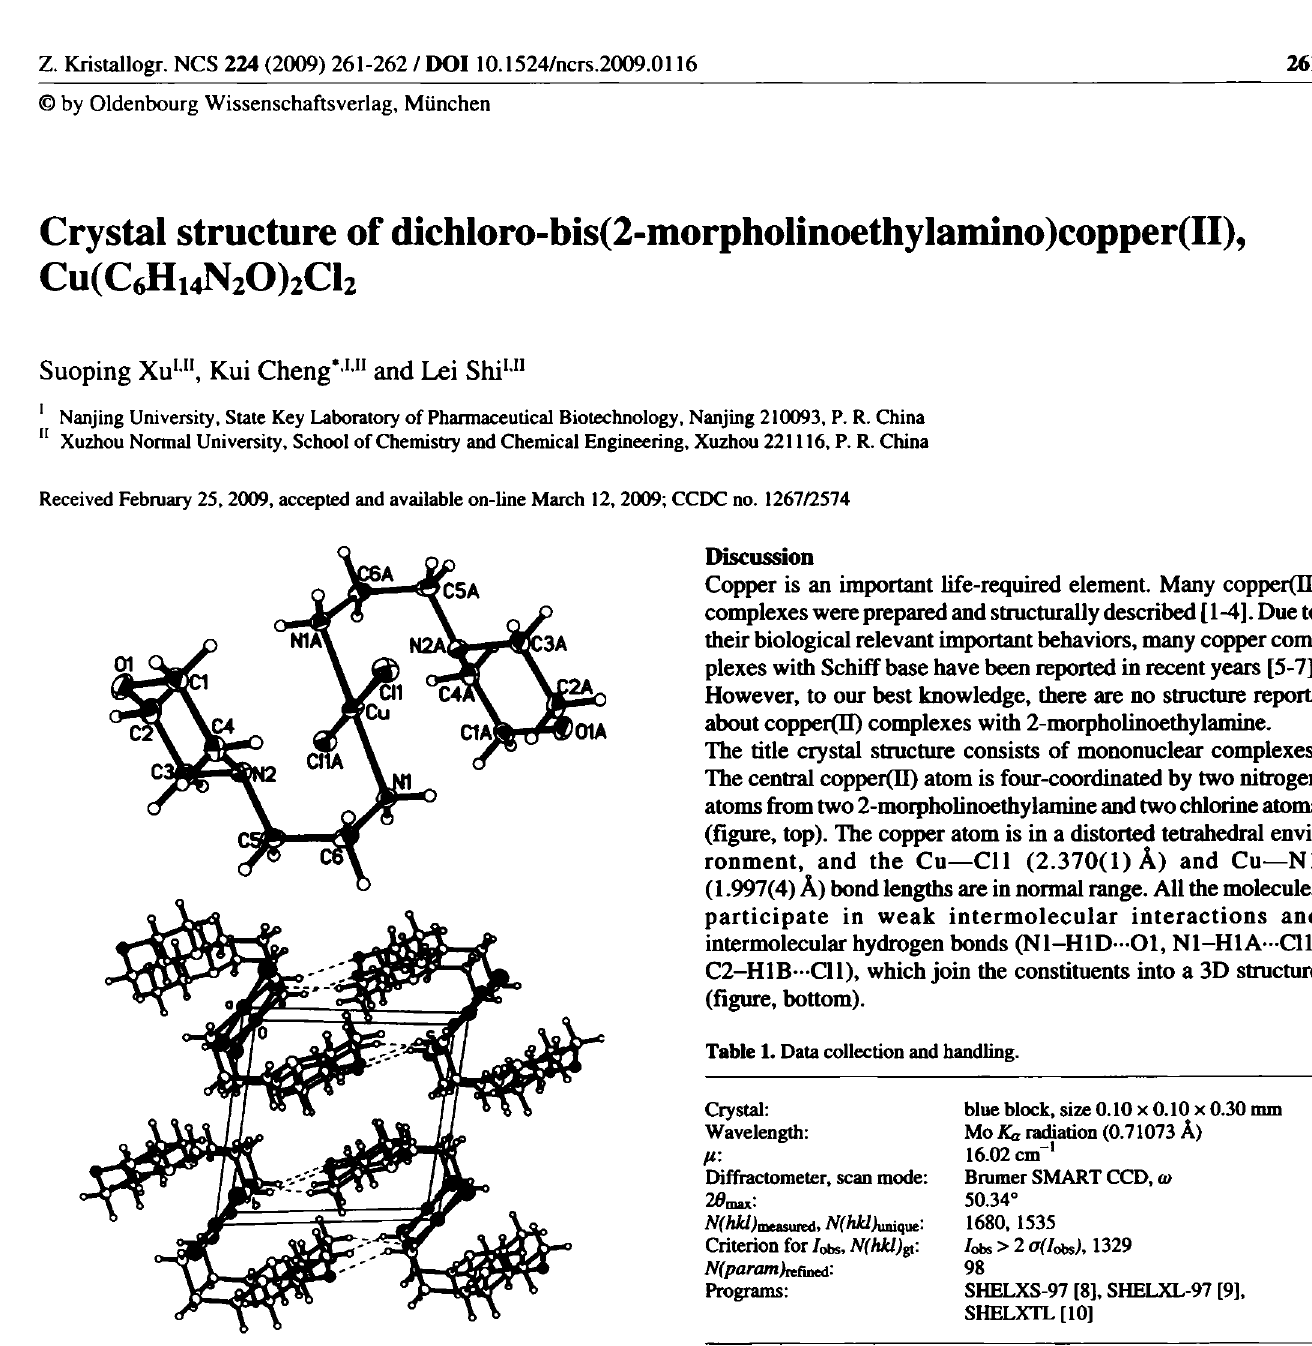
Table 2. Atomic coordinates and displacement parameters (in A 2